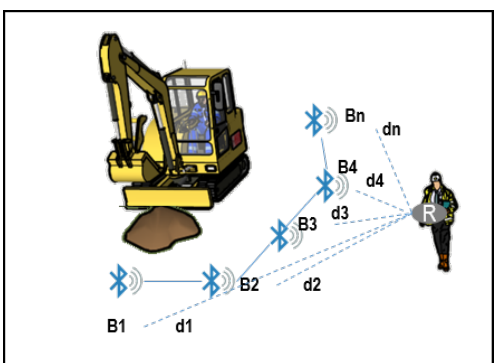
Figure 9. Scenario 1. Virtual fence on excavation